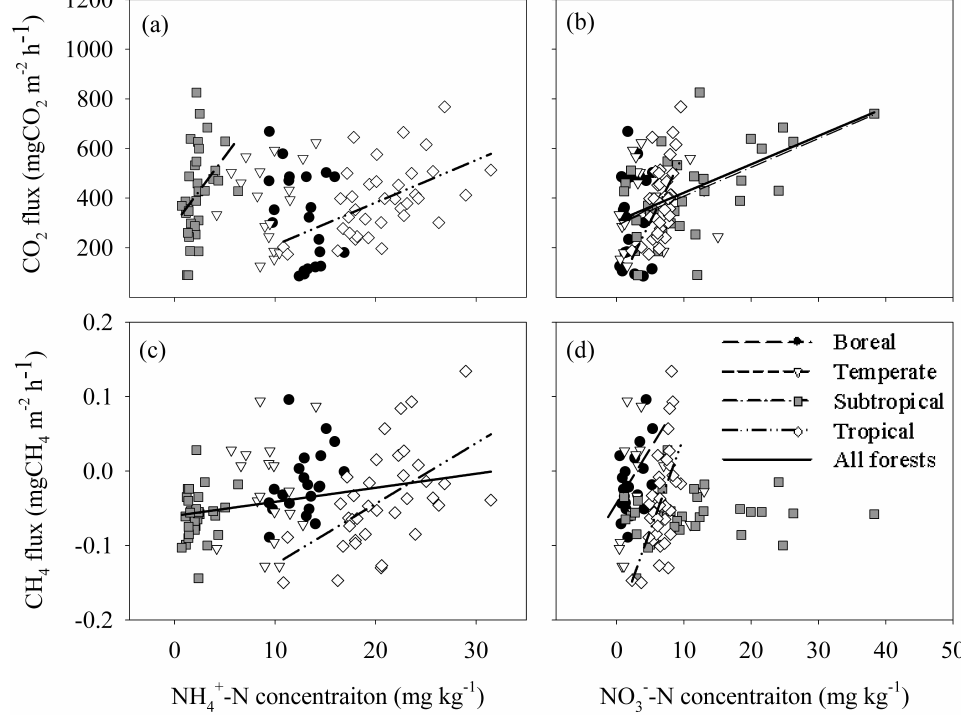
Fig. 6. Relationships of CO 2 and CH 4 fluxes to soil NH +